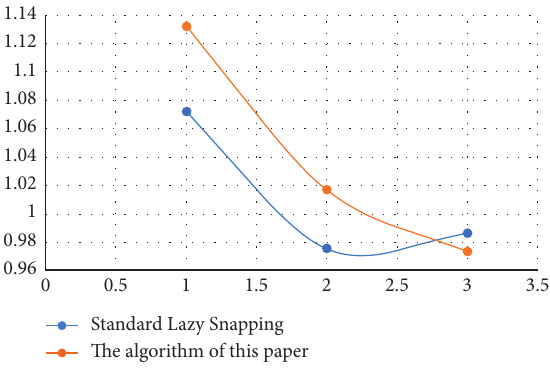
Figure 5: Comparison of algorithm running